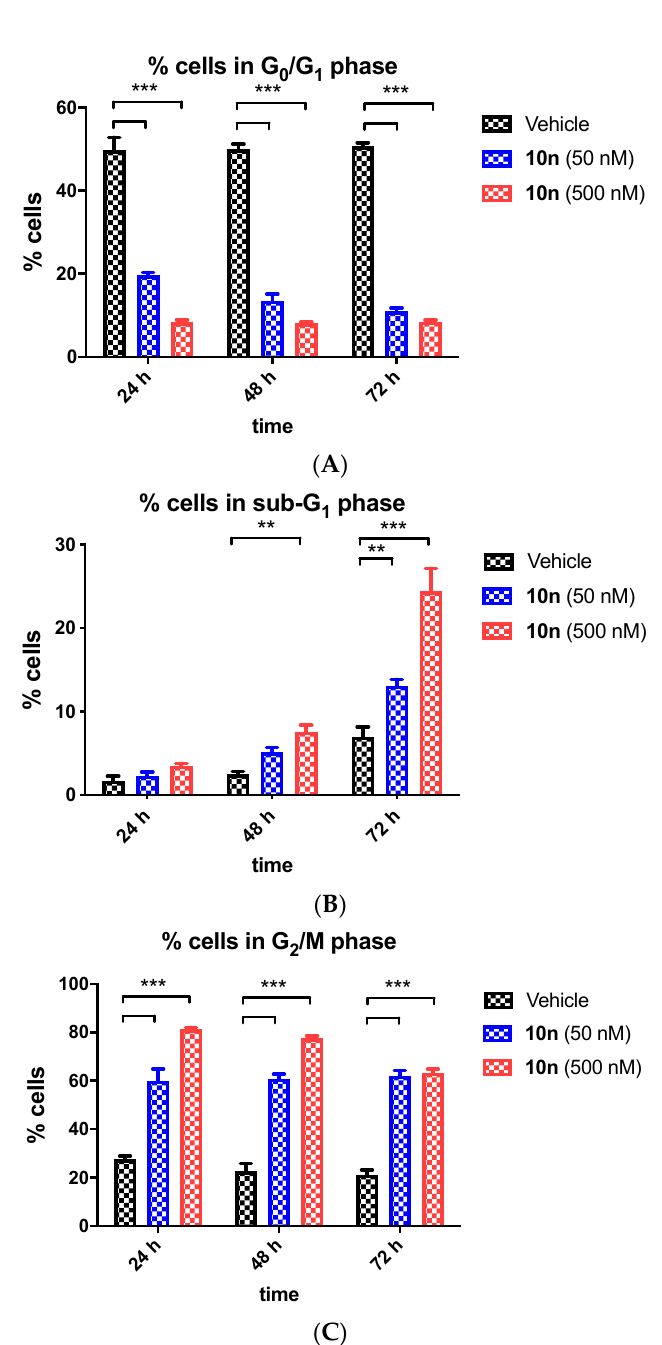
Figure 5. Compound 10n cells induced G 2 /M arrest followed by apoptosis in a time dependent manner in MCF-7 cells. ( A ) % of cells in G 0 /G 1 phase, ( B ) % of cells in sub-G 1 phase and ( C ) % of cells in G 2 /M phase. Cells were treated with either vehicle control (v) (0.1% ethanol ( v/v )) or compound 10n (50 and 500 nM) for 24, 48 or 72 h. Cells were then fixed, stained with PI and analysed using flow cytometry. Cell cycle analysis was performed on histograms of gated counts per DNA area (FL2-A). The number of cells with <2 N (sub-G 1 ), 2 N (G 0 /G 1 ) and 4 N (G 2 /M) DNA content was determined with CellQuest software. Values represent the mean ± SEM for three separate experiments. Two-Way ANOVA (Bonferroni post-test) was used to test for statistical significance (**, p < 0.05; ***, p < 0.001).